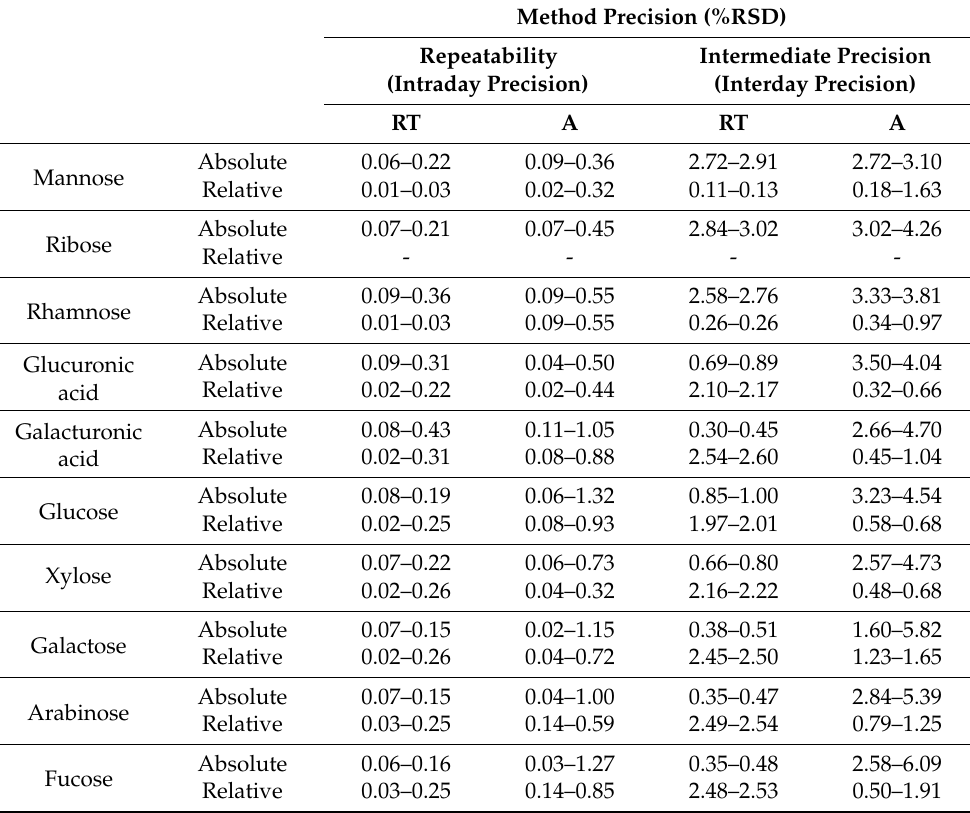
Table 2. The precision parameters for the developed HPLC-DAD method for the analysis of PMP– sugar derivatives (RT—retention time; A—area).